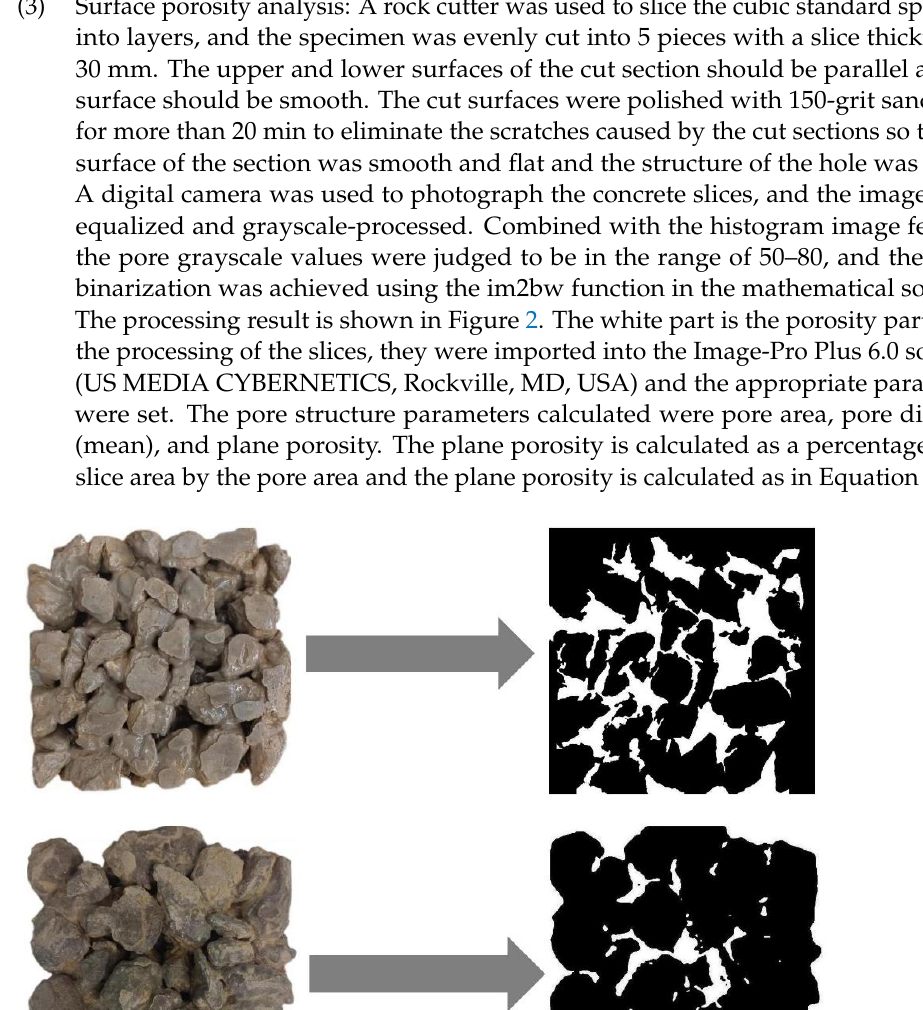
( c ) Figure 3. Planting experiment. ( a ) Tall fescue seeds; ( b ) Surface planting structures; ( c ) The measurement of root length. (6) Determination of biomass and elemental levels in plant leaves and roots: After 50 days of growth, tall fescue plants grown with different planting methods and planting densities were taken as samples. The tall fescue plants were removed from the planting concrete completely; the stems and leaves were separated from the root system with scissors, and the root system was rinsed with distilled water. Each pot of stem and root samples was separately placed in a 115 °C oven for 15 min to inactivate the enzymes and then dried at 75 °C. Three tall fescue plants were taken for measuring the biomass of stems, leaves, and roots, and another three plants were